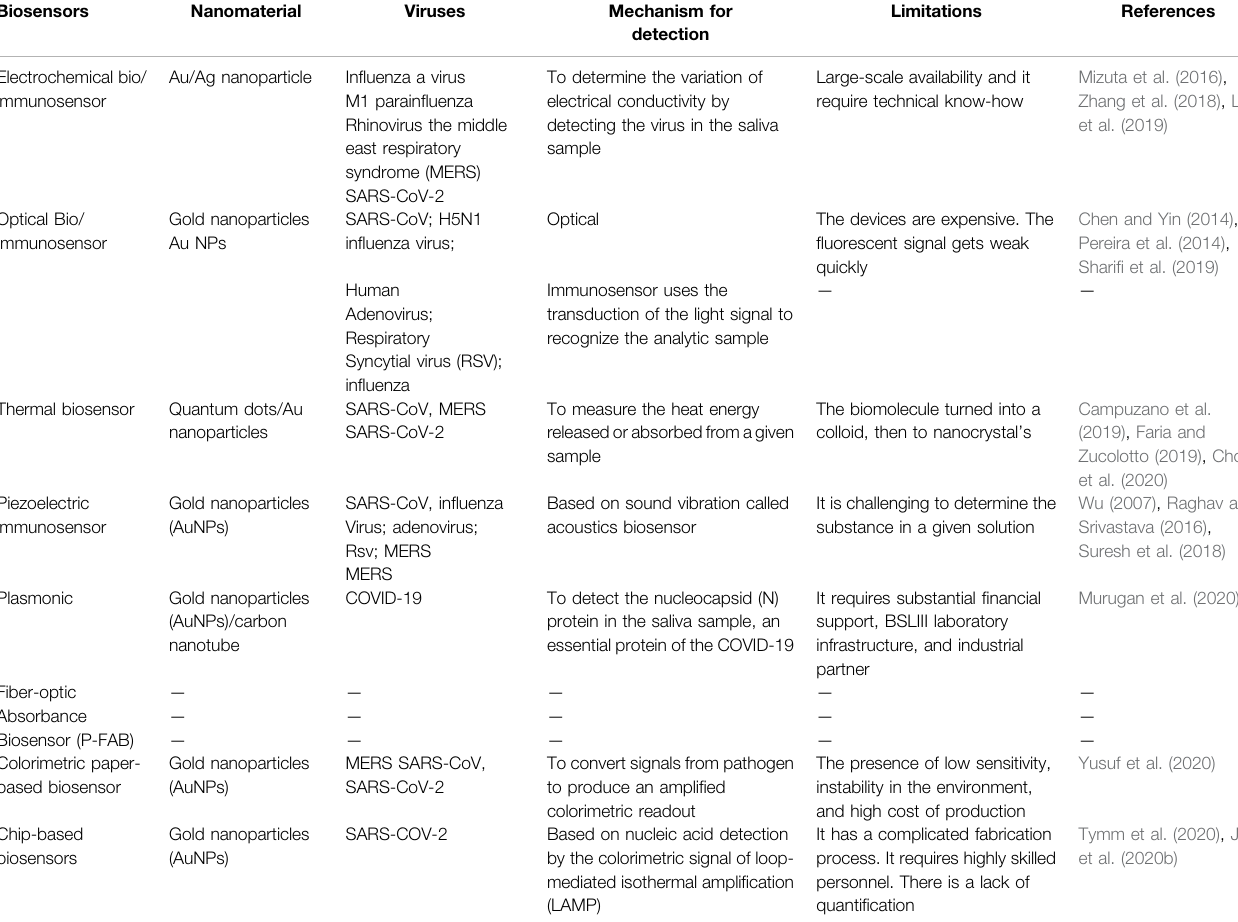
TABLE 2 | Summarized the application of various nanomaterial in the sensing system of SARS-CoV and other related